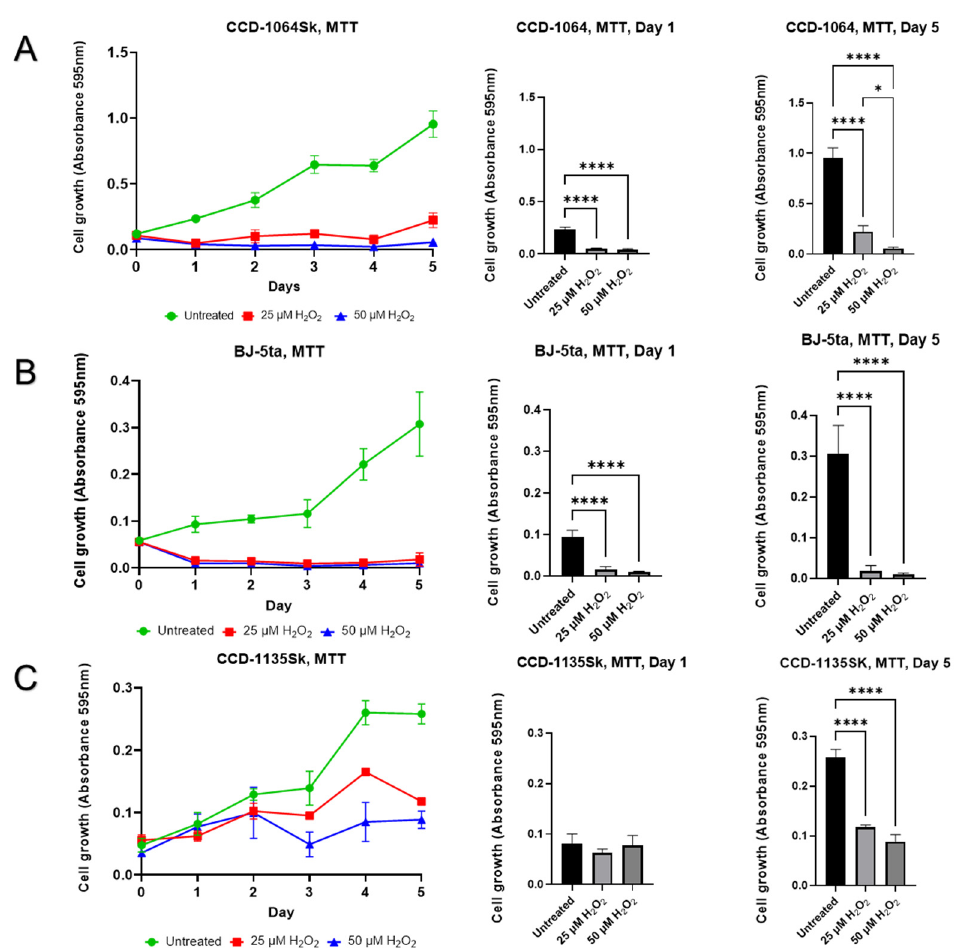
Figure 11. Viability of dermal fibroblasts estimated by MTT assay five days after a single treatment of 25 µ M and 50 µ M of H 2 O 2 (one-step senescence model). ( A ) CCD-1064Sk, p.11; ( B ) BJ-5ta, p.42; ( C ) CCD-1135Sk, p.12. Data were analyzed with a one-way ANOVA test (Tukey post-hoc multiple comparison test). Significance (p) is indicated within the figures using the following scale: *, p < 0.05; p < 0.001; ****, p < 0.0001. Bars represent mean ± SD.